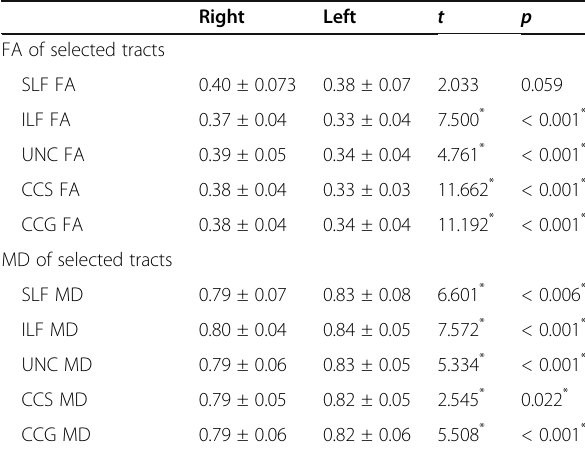
Table 5 Fractional anisotropy and mean diffusivity at both right and left hemispheres in diabetics with mild cognitive impairment ( n = 17)